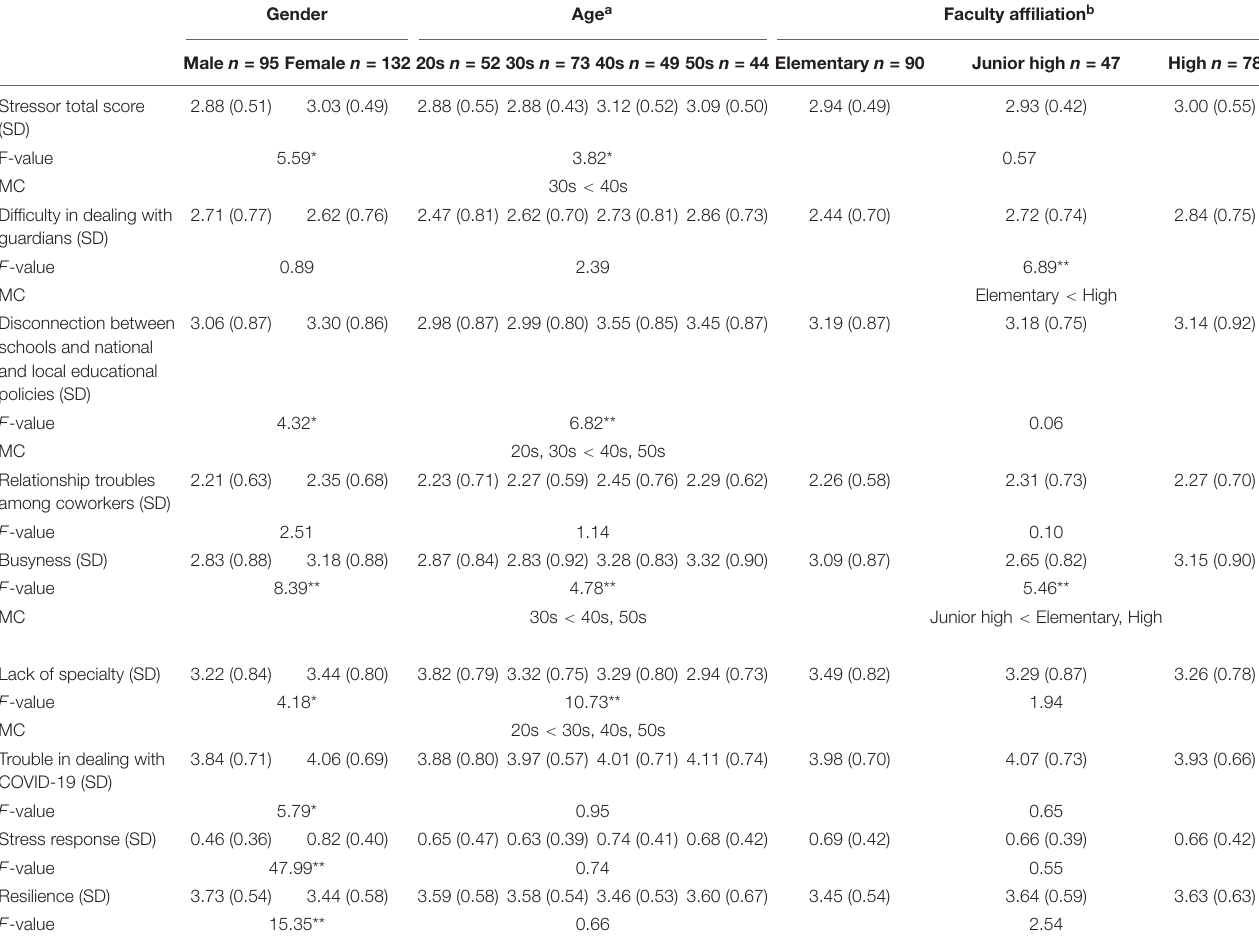
TABLE 3 | Comparison of mean scores for each scale and factor by performing one-way analysis of variance (gender, age, and faculty affiliation). Gender Age a Faculty affiliation